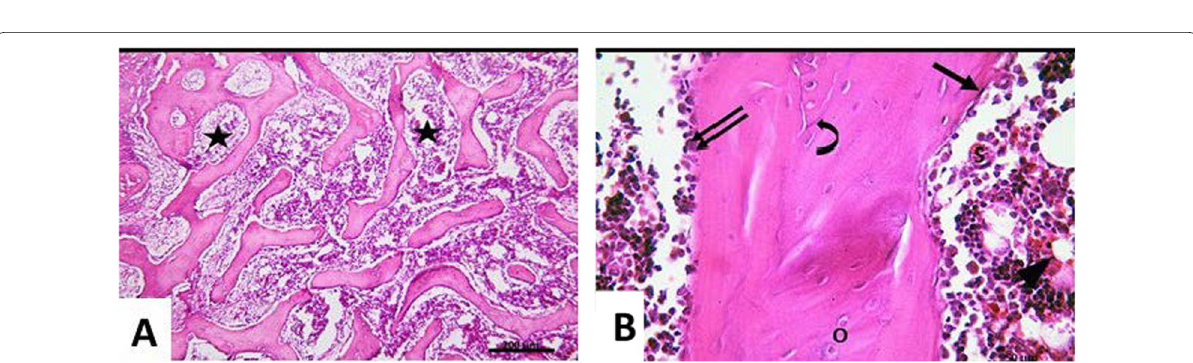
Fig. 4 H&E stained Sections of the lower femur of control non ketamine treated rat showed cancellous bone formed of branching and anastomosing bone trabeculae with bone marrow spaces in between ( A magnification H&E containing osteoprogenitor cells and osteoblasts. Osteocytes were seen inside their lacunae. Bone marrow was formed of haemopoietic cells,